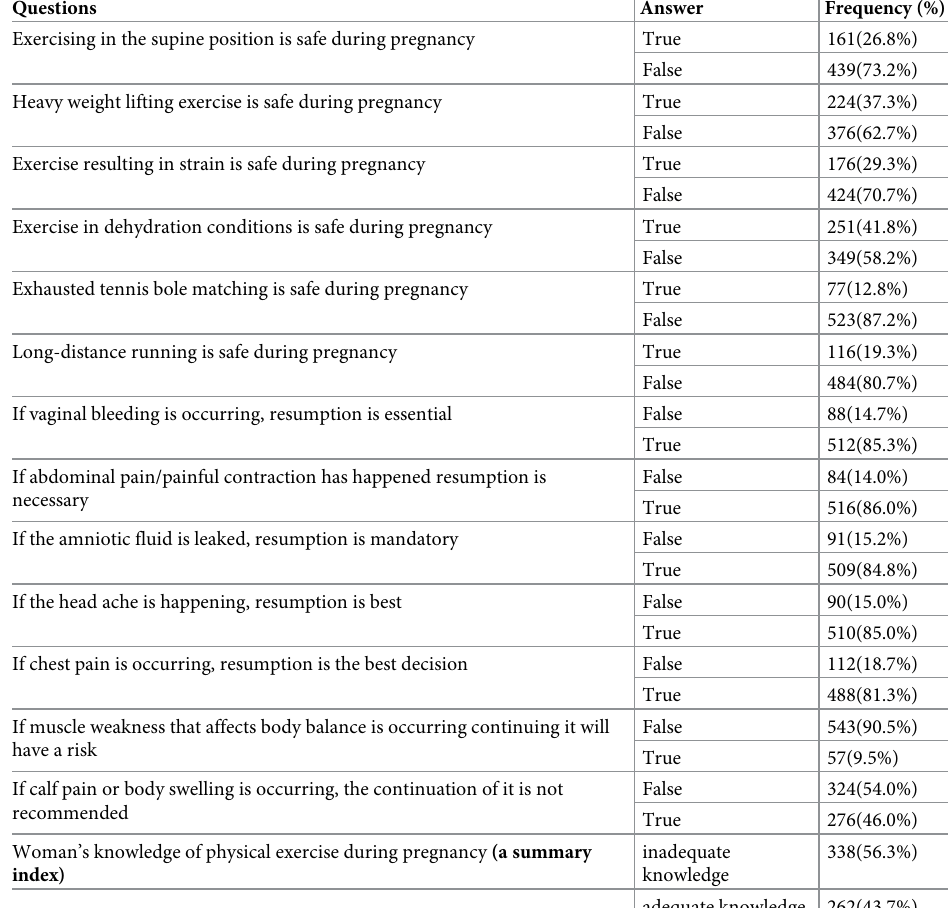
Table 7. Women’s knowledge of the contraindications of antenatal physical exercise during pregnancy among pregnant women in Hawassa city, Sidama Regional State, Ethiopia, 2021. Questions Answer Frequency